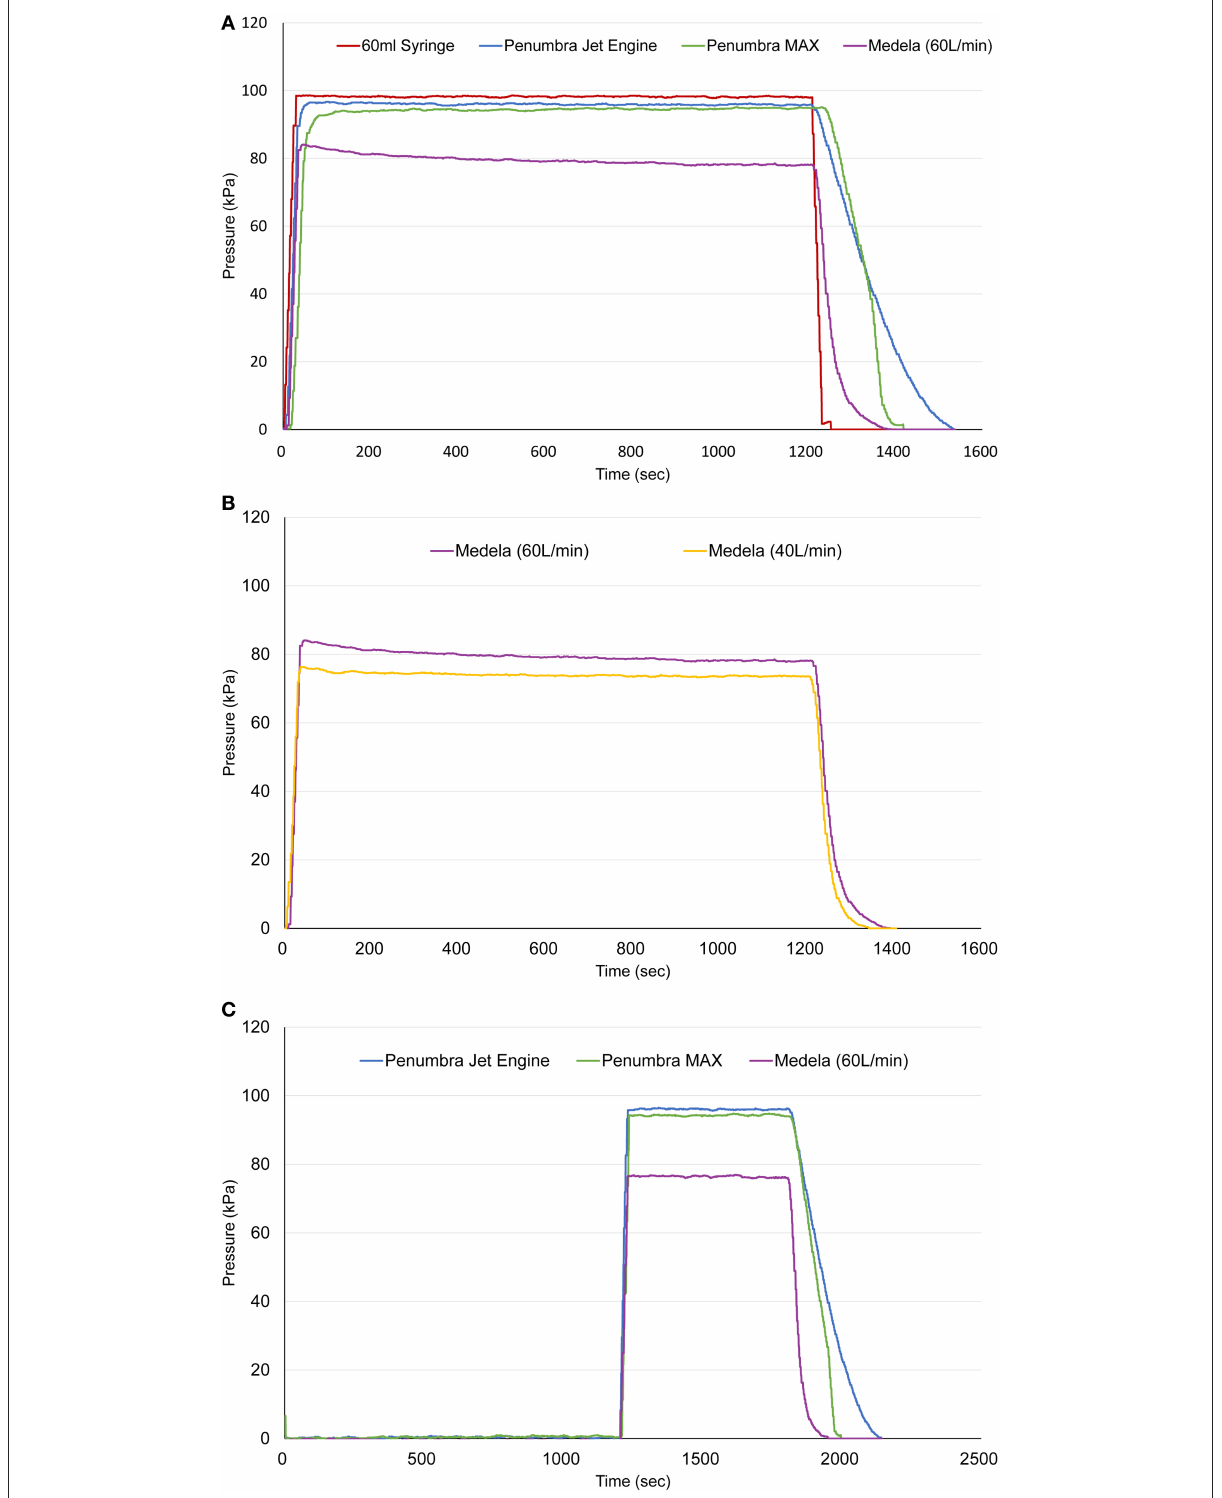
FIGURE3 (A) Comparison of vacuum pressure between the 60cc syringe and other automatic pumps. (B) Vacuum pressure according to flow rate in the Stryker Medela AXS Universal Aspiration Set. (C) Vacuum pressures of automatic pumps at 20min after turning on the